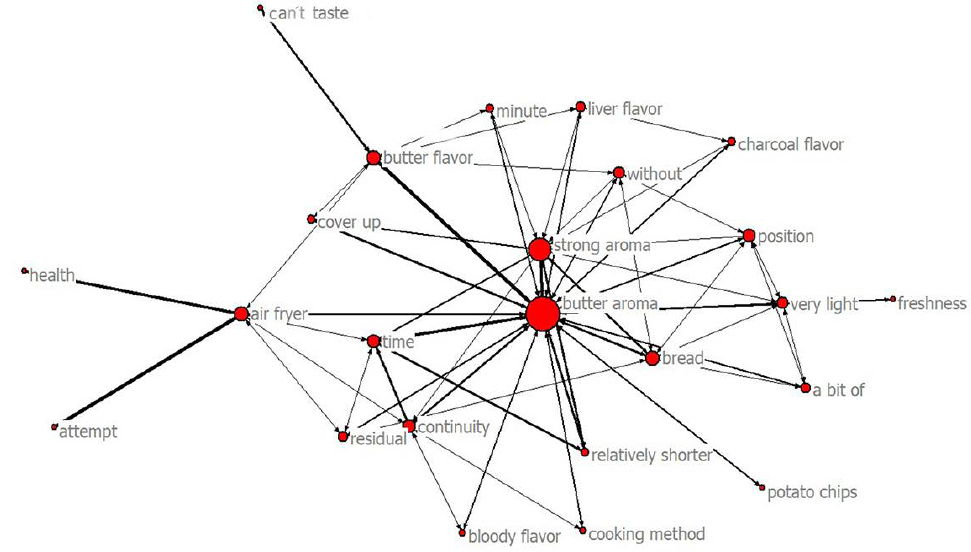
Figure 4. In the network diagram, nodes represent factors, and the connections between nodes represent the relationship between factors. The higher the centrality of the node degree, the more the point is in the center of the network. The thickness of the connection between nodes is positively correlated with the closeness of the relationship.